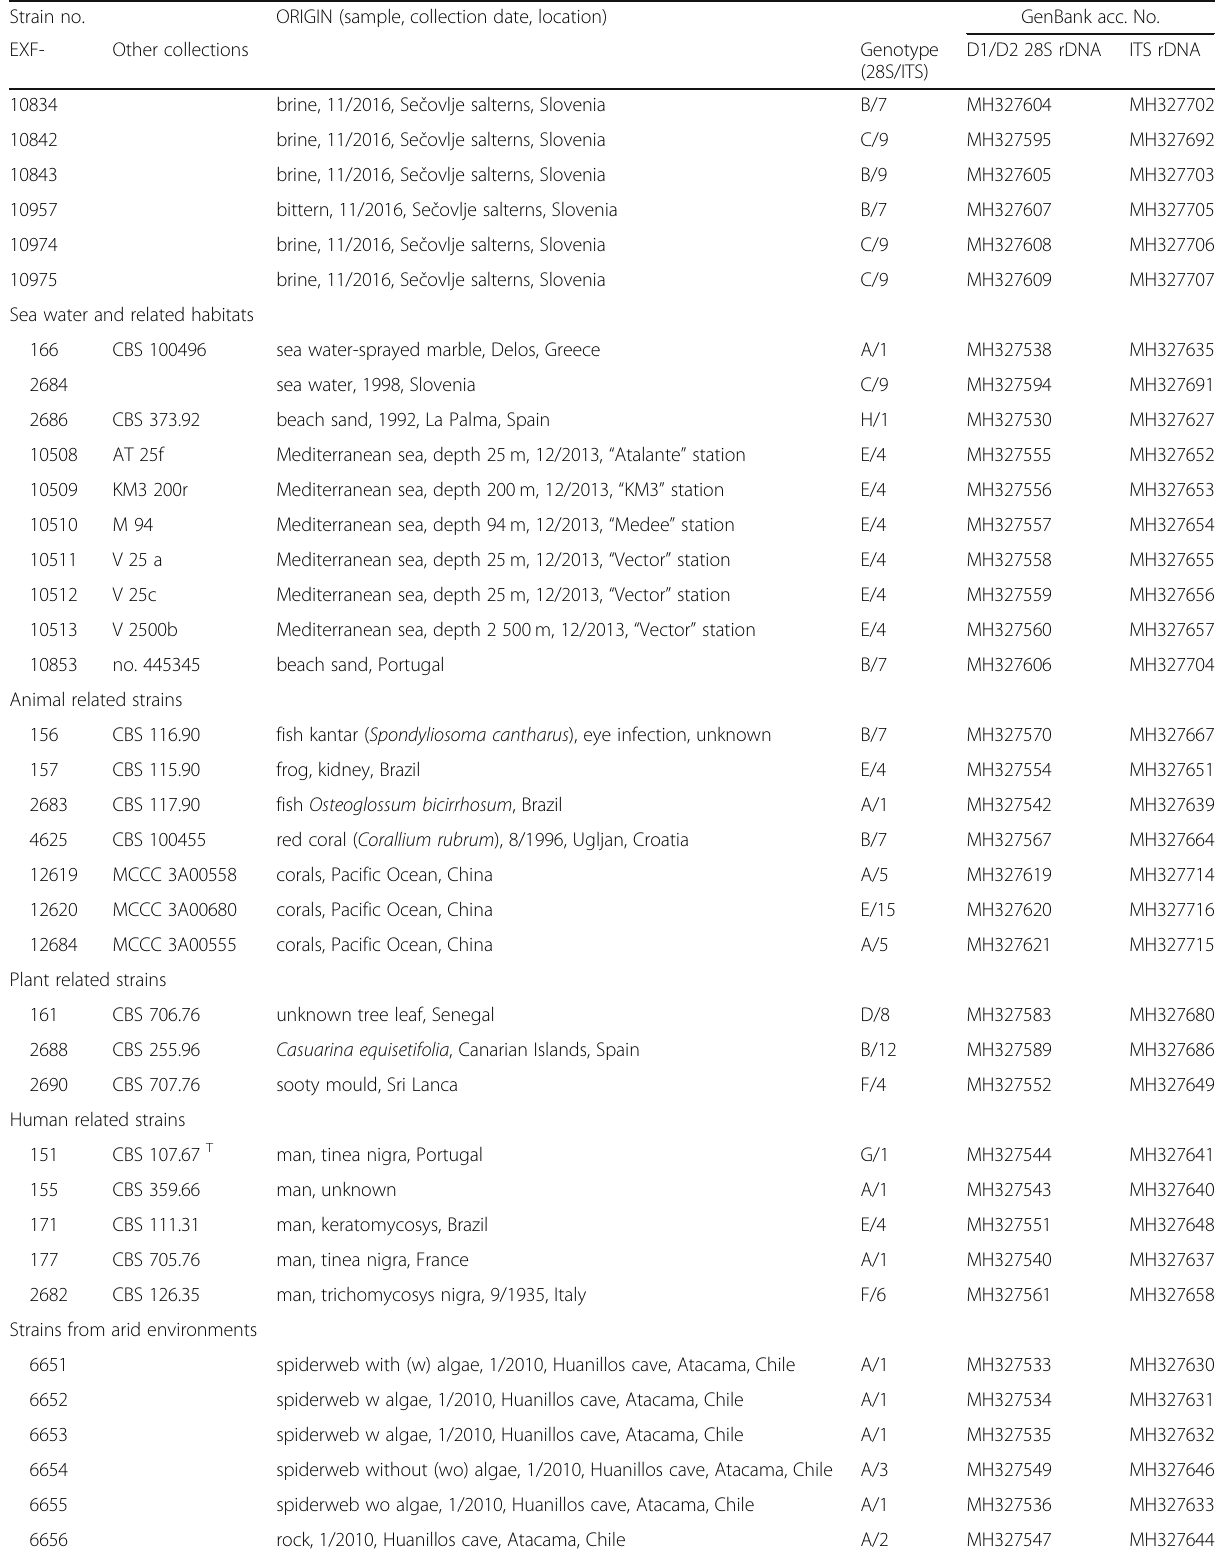
Table 1 Hortaea werneckii strains treated in this study (Continued) Strain